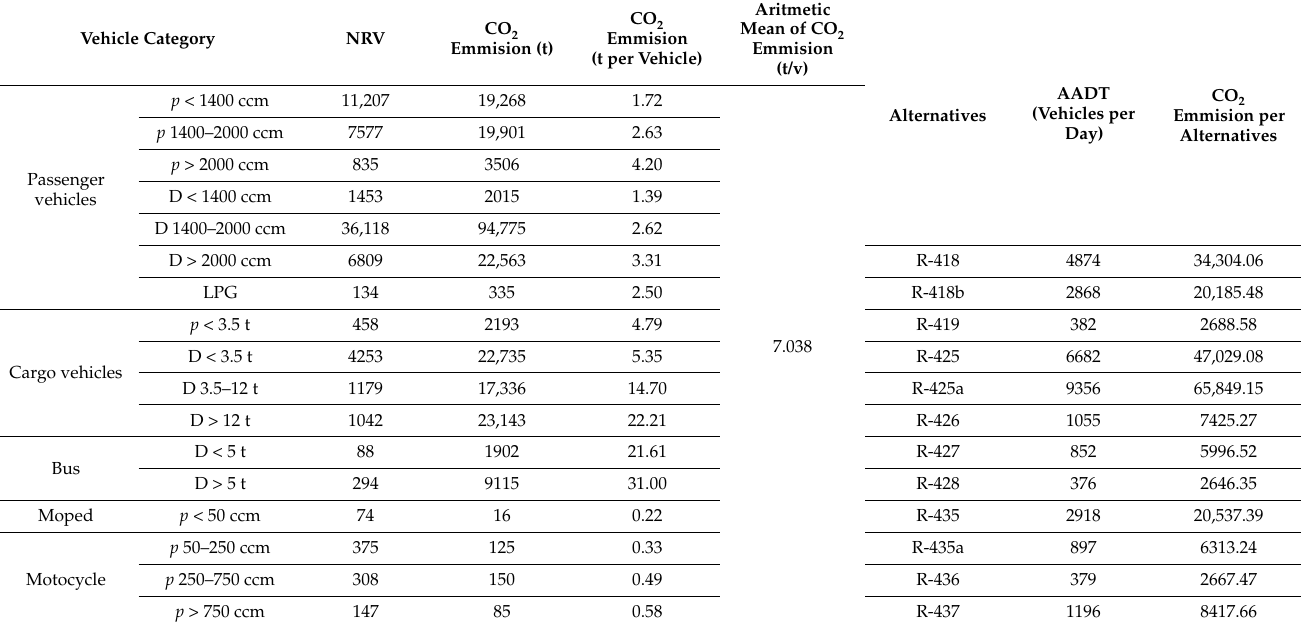
Table 3. Relationship between technical and ecological criterion of HSG.